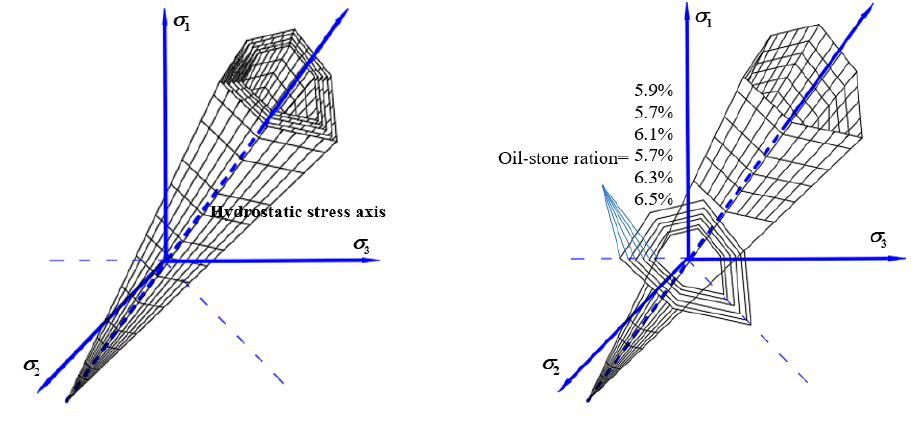
Figure 14. Linear failure criterion under different test conditions.